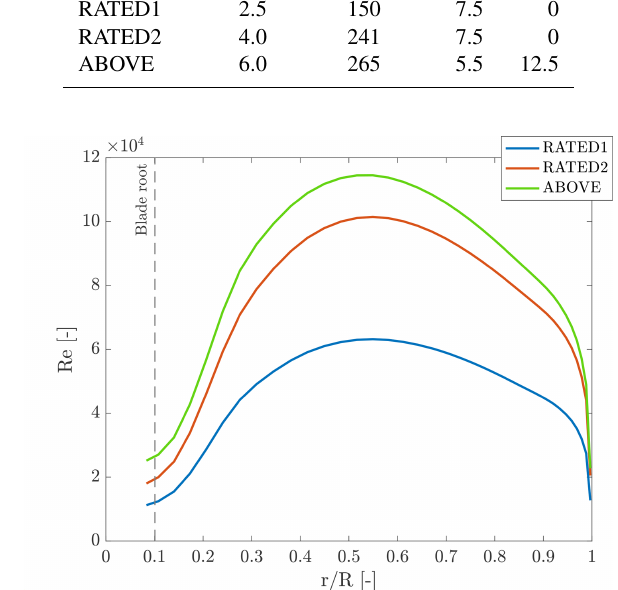
Figure 1. Reynolds number as a function of non-dimensional radial position ( r/R ) for the turbine-model blade in the three operating conditions of the experiment. The dashed vertical line indicates the radial position at which the circular cross section of the blade